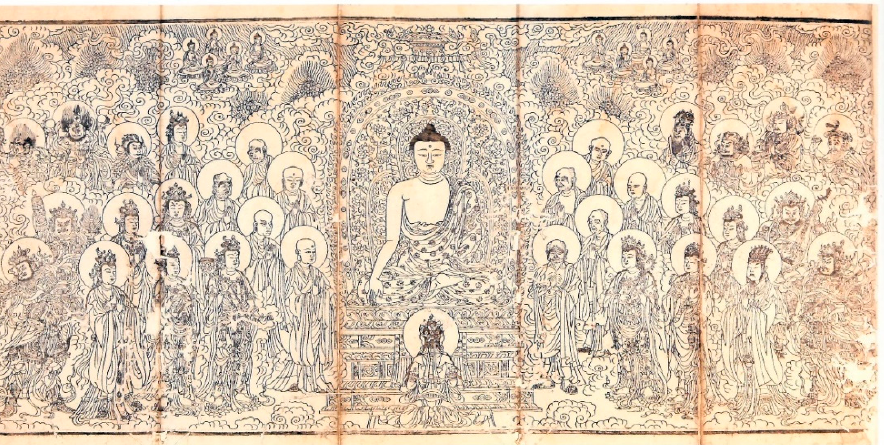
Figure 6. Lotus Sutra (Gyeonseongam edition), published at Gyeonseongam Hermitage, Joseon (1459), Sutra illustration 25.0 × 53.0 cm, Sairaiji Temple, Japan (Dongguk University Museum 2014, p. 39).